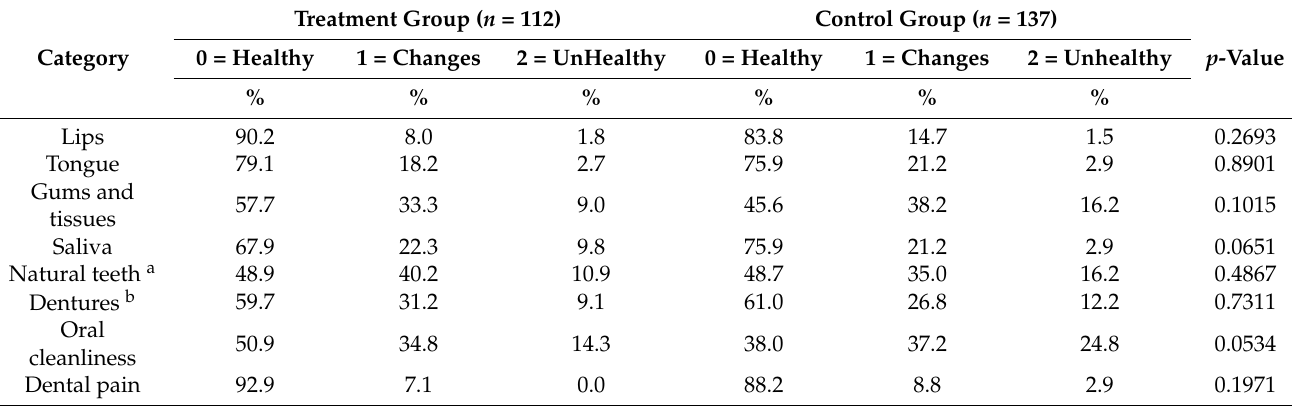
Table 2. Oral Health Assessment Tool (OHAT) scores for participants of the treatment group and participants of the control